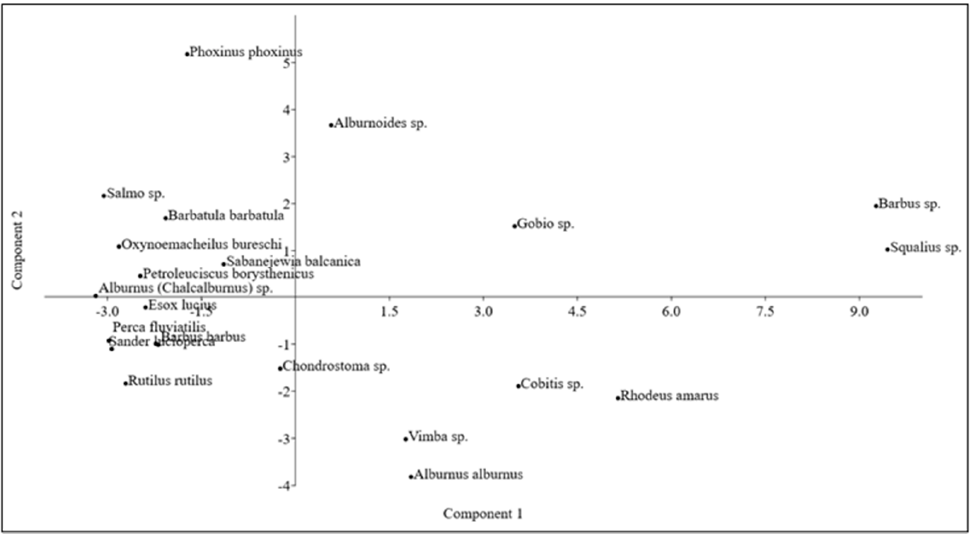
Figure 2. PCA scatterplot of Bulgarian fish species inhabiting Bulgarian rivers with an occurrence of more than 10% in each river